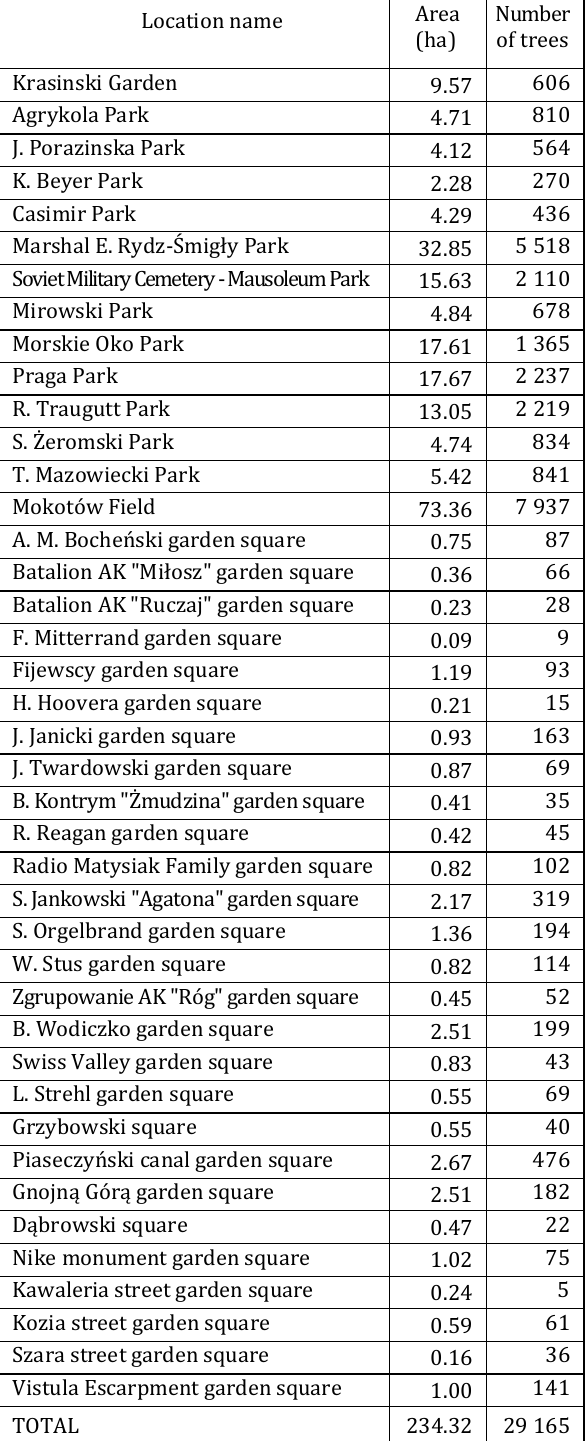
Table 1. Urban green areas included in the